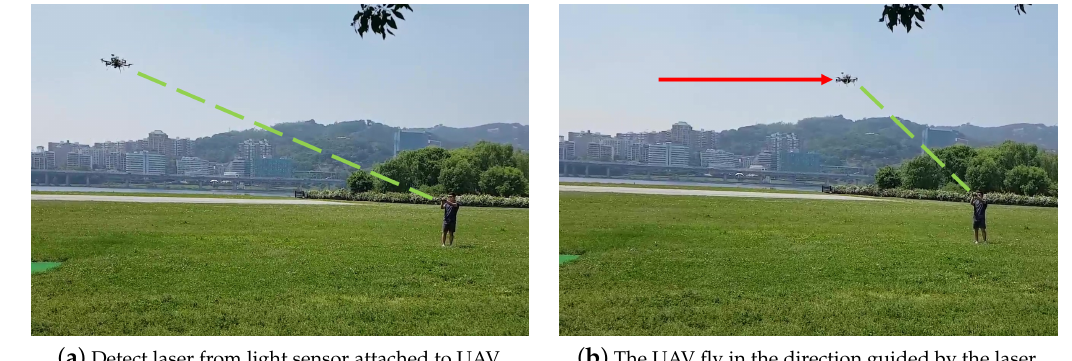
Figure 9. Laser guidance demonstration.